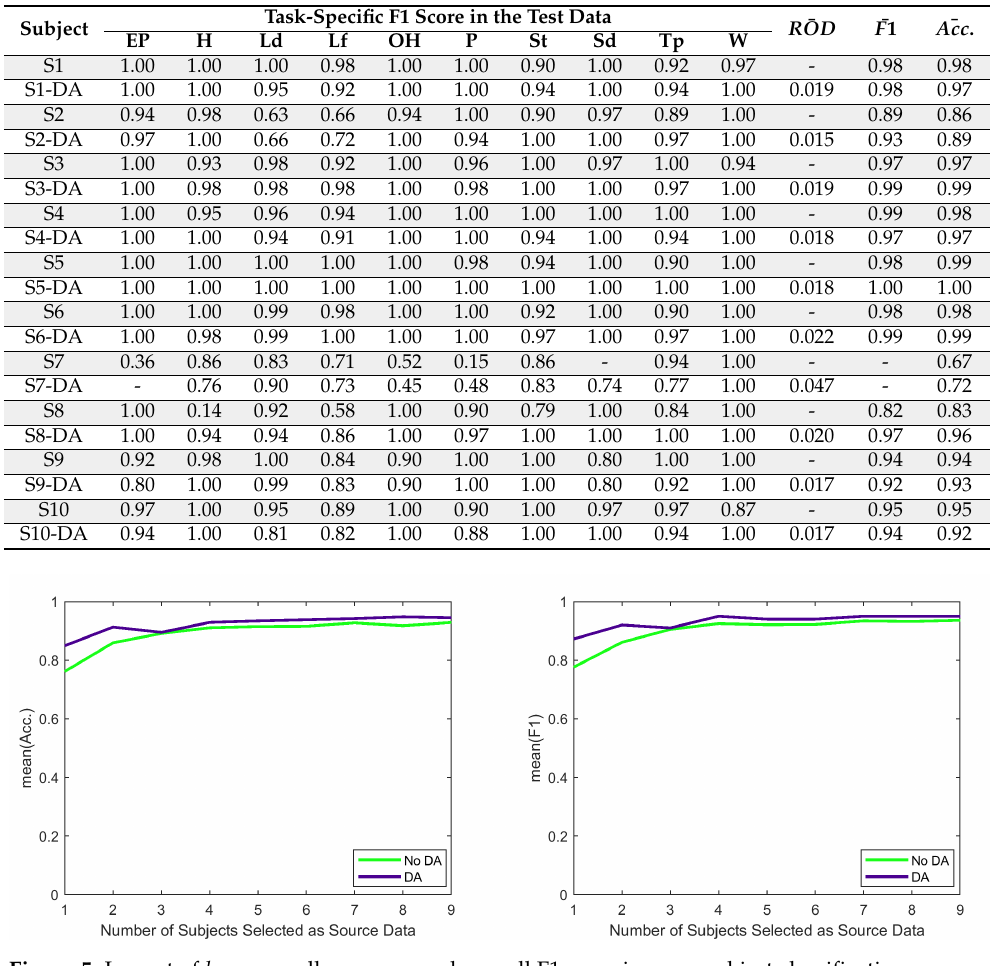
Figure 5. Impact of k on overall accuracy and overall F1 score in cross-subject classification. Table 5. The number of excluded cases to obtain overall F1 score for cross-subject classification (totally, there were 10 Subjects × 10 Tasks = 100 Cases for each